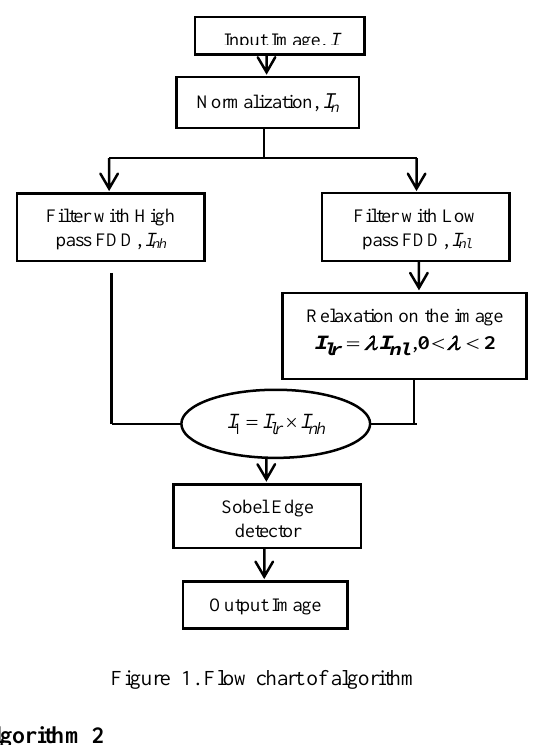
Figure 1. Flow chart of